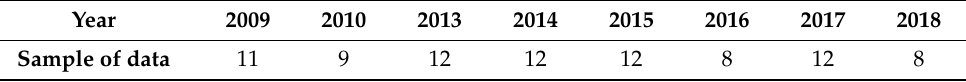
Table 2. Summary of statistical parameters of input and output variables (n =